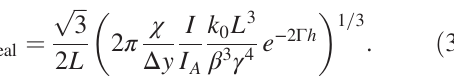
FIG. 5. Plot of gain as a function of input electric field in a CFEL